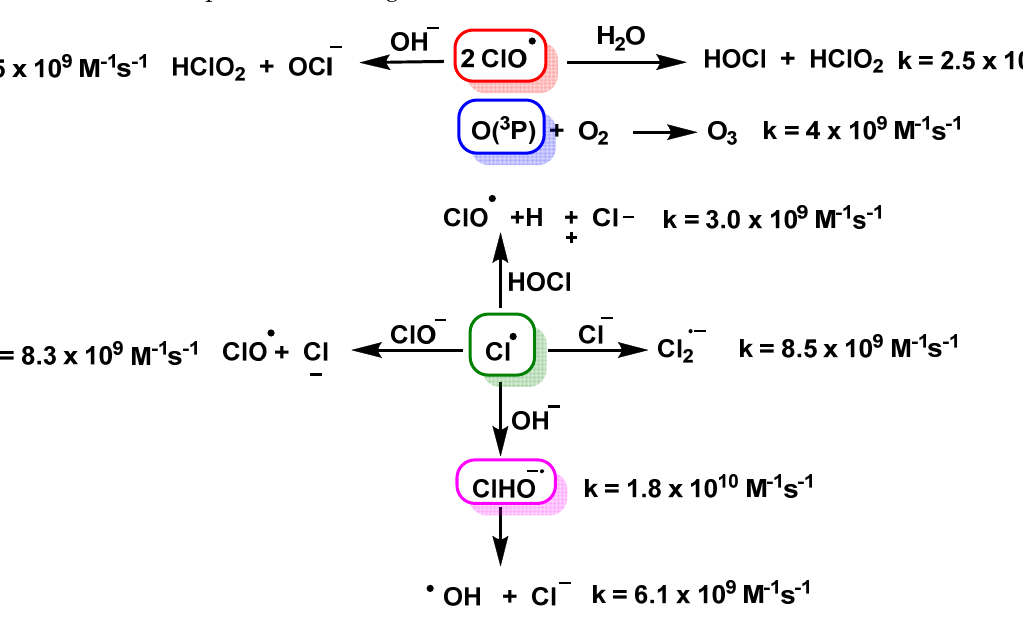
Figure 22. The generated ClO • , O(3P), and Cl • undergo chain reactions to generate secondary reactive species. The degradation of ClO 2 under UVC radiation accelerates the tendency of chlorite and chlorate formation compared to ClO 2 alone. In addition, chlorite and chlorate can also be generated from radical-radical interactions [56–59], Figure